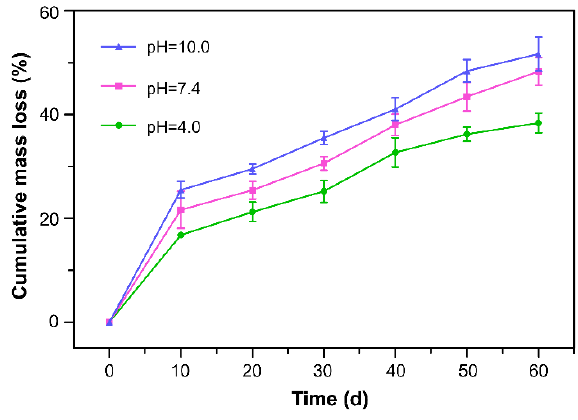
Figure 9. Degradation of AgNPs ‐ PEM ‐ SS/Agar film at pH 4.0, 7.4, 10.0.